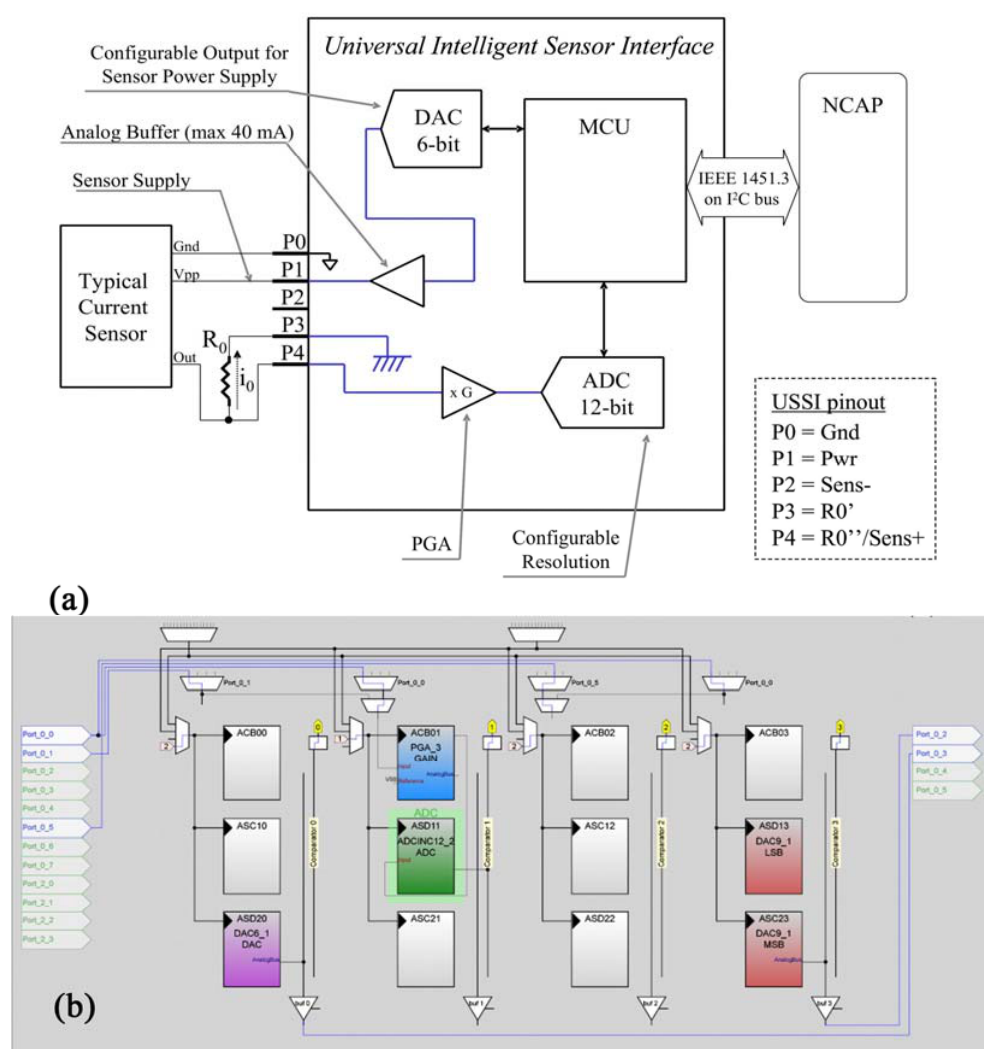
Figure 7. Current Output Sensors: (a) Logical scheme of UISI conditioning front-end and (b) screen-shot of related implementation in PSoC device through by means of Graphic